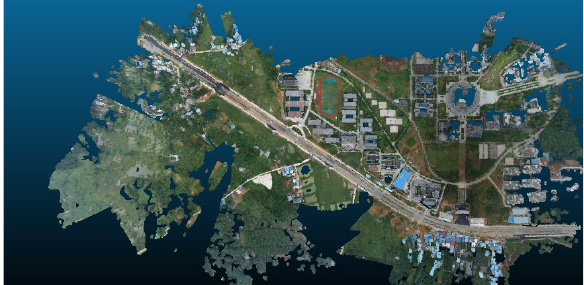
Figure 3 Digital Surface Model (DSM) result